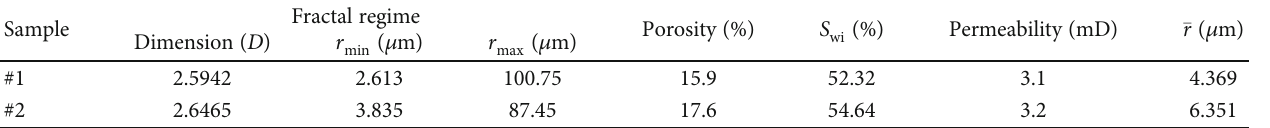
Table 1: Parameters of the